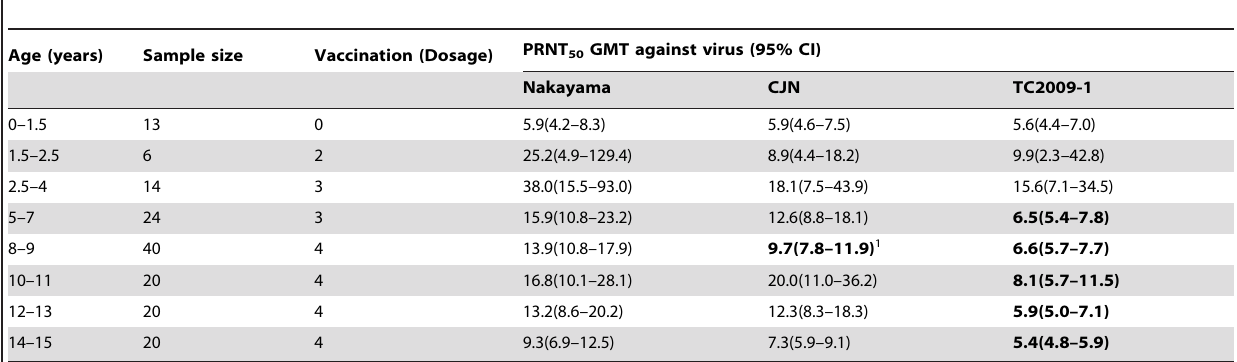
Table 1. Geometric mean titers (GMT) of strain-specific neutralizing antibody against vaccine and field-isolated genotype III and I viruses among serum samples collected from children immunized with inactivated JEV Nakayama